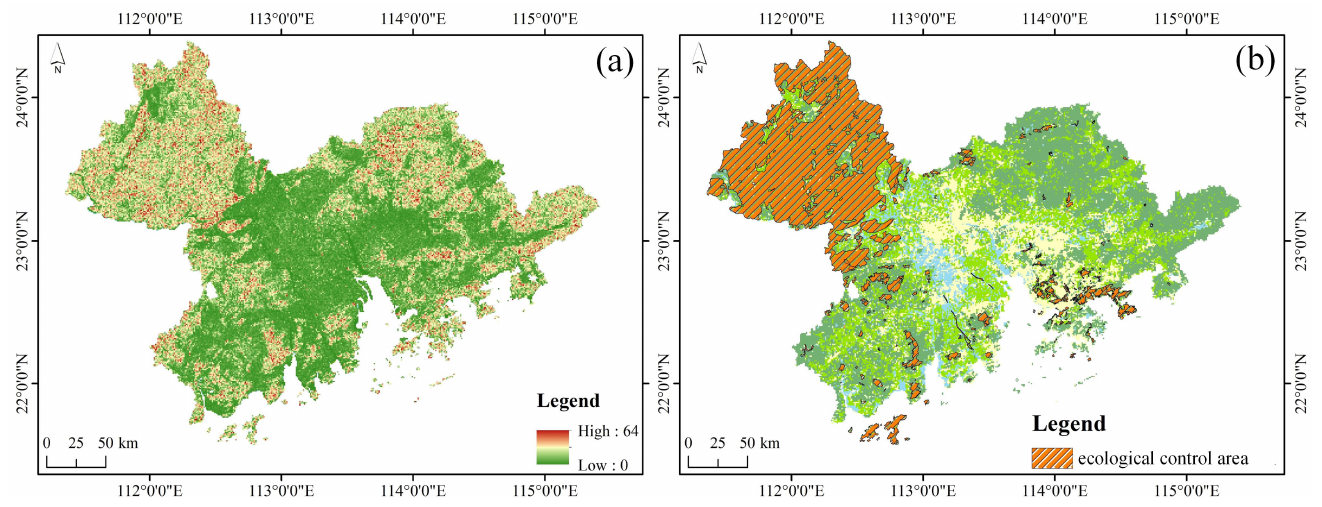
Figure 8. Constraints in GBA, in relation to ( a ) the slope constraint and ( b ) ecological control area, that cannot be changed.